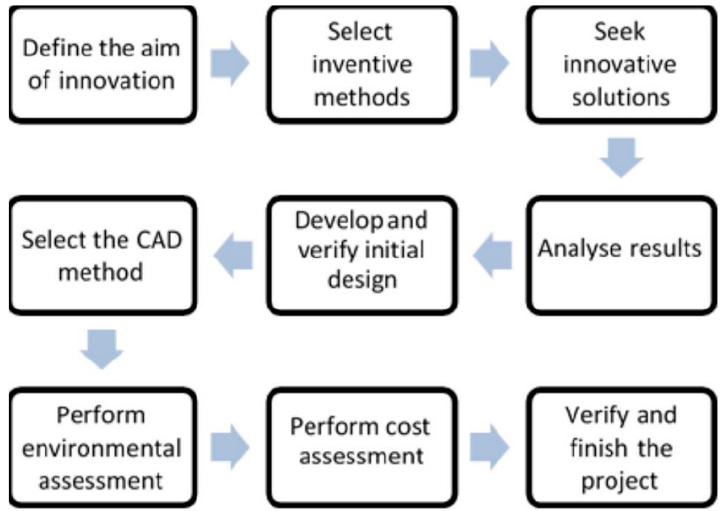
Figure 1. Stages of eco-innovation.